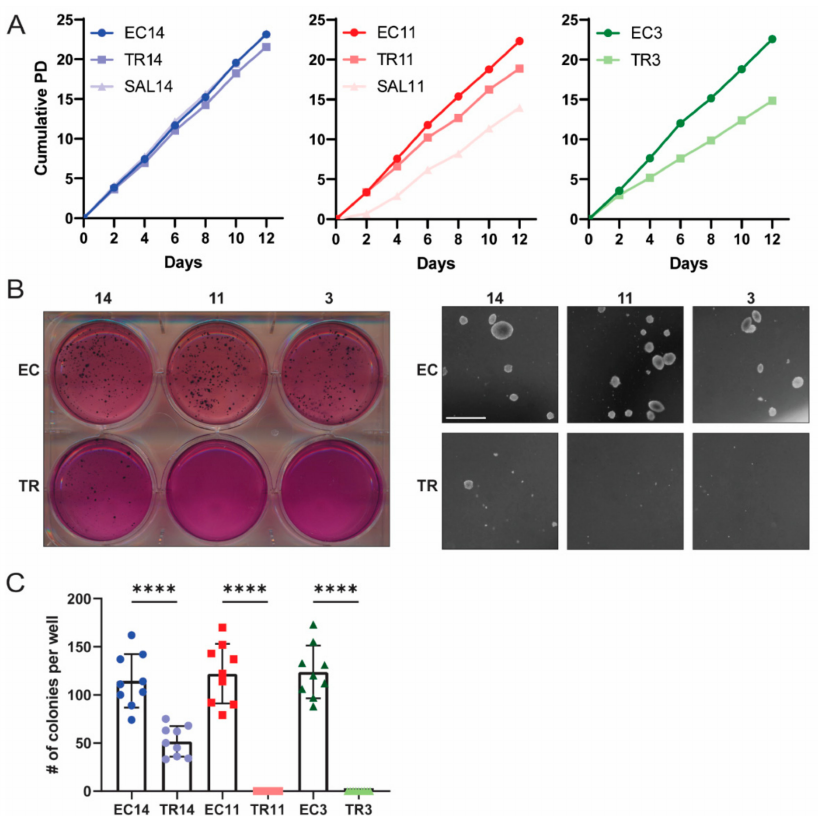
Figure 3. Thioridazine-differentiated cells have a reduced proliferation rate and reduced capacity for anchorage-independent growth. ( A ) Population doubling plots for the indicated EC cell lines and their thioridazine- and salinomycin-differentiated derivatives. ( B ) Representative whole-plate and microscopic images from soft agar growth assays assessing anchorage-independent growth of EC and thioridazine-differentiated cells. Scale bar = 1 mm ( C ) Quantification of soft agar growth assay experiments. The number of colonies was counted per well across three independent experiments, each with three technical replicates. Data are mean values ± standard deviation. **** p < 0.0001 (Mann–Whitney